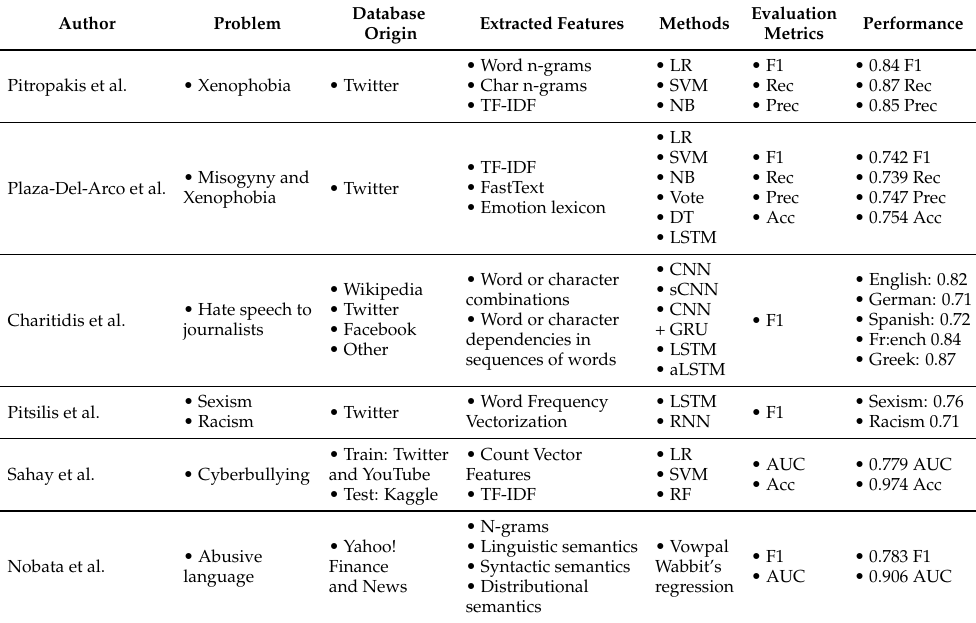
Table 1. Summary of previous work in terms of the problem they address, the data source used, features extracted, classifiers used, evaluation metrics, and the result obtained in the